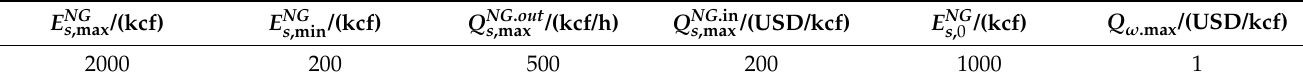
Table A5. Parameters of gas storage facility.